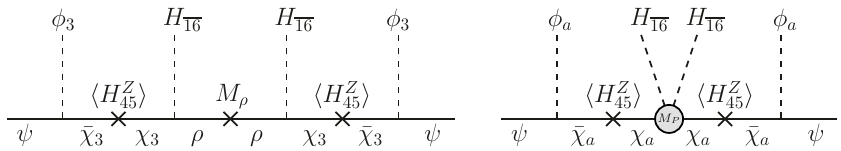
Figure 3 . Diagrams coupling to H . One copy of the right diagram may be drawn for each of 16 a = 1 ; 2 ; 3, although for a = 3, its contribution is negligible compared to the left diagram. When (cid:13)avons acquire VEVs, these give the RH neutrino mass